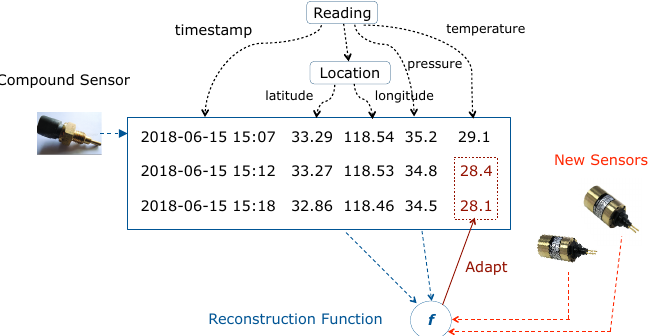
Figure 1. Example of a compound weather sensor that consists of three individual sensors. The reconstruction function f reconstructs failed temperature values from the two remaining working sensors (blue arrows) and the two new sensors (red